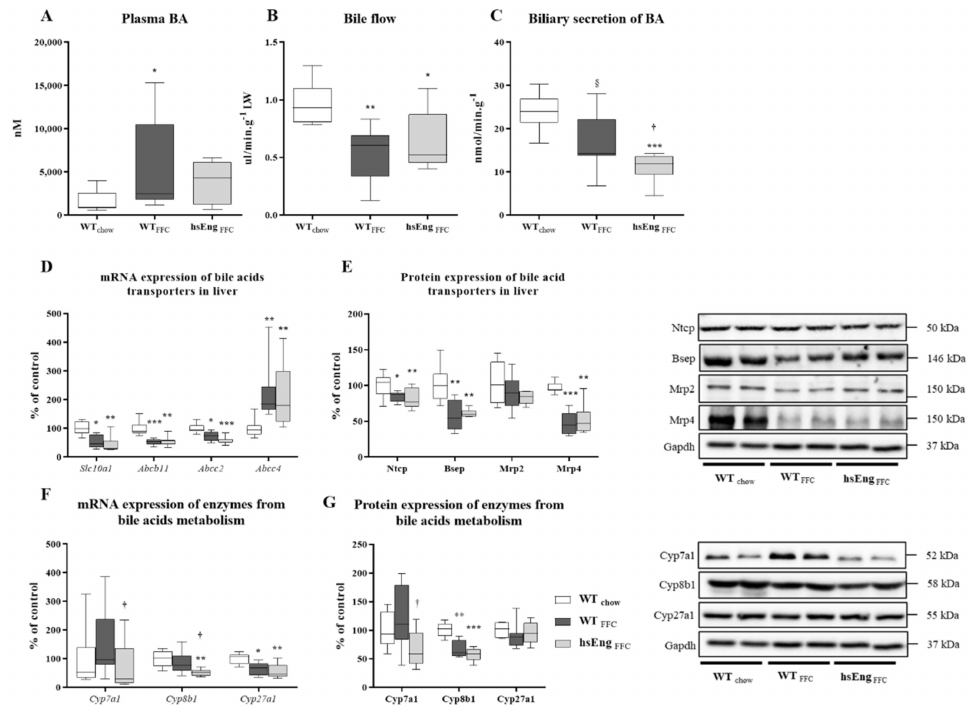
Figure 7. Bile acid metabolism in the liver in WT and hsEng mice. Plasma concentration of BA ( A ). Bile flow rate ( B ). Biliary elimination of BA ( C ). mRNA ( D ) and protein ( E ) expression of transporters involved in BA uptake to the liver ( Slc10a1 / Ntcp), bile production ( Abcb11 / Bsep, Abcc2 / Mrp2), and BA e ffl ux to plasma ( Abcc4 / Mrp4). mRNA ( F ) and protein ( G ) expression of liver enzymes involved in BA synthesis from cholesterol (Cyp7a1, Cyp8b1, Cyp27a1). The data are presented as median with box and whiskers representing the interquartile range and 5th–95th percentiles ( n = 8). * p < 0.05, ** p <